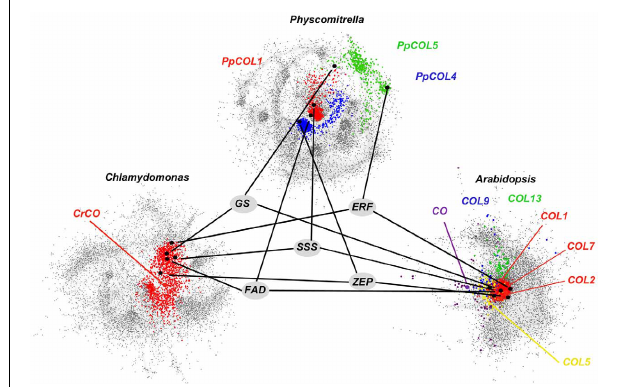
FIGURE 2 | Gene co-expression networks for Chlamydomonas , Physcomitrella , and Arabidopsis . In the networks, nodes represent genes and edges between nodes show significant co-expression relation between them. CrCO , PpCOLs, and AtCOLs and their neighborhoods (genes three edges apart) are highlighted with different colors. In the Chlamydomonas network (bottom left) CrCO and its neighborhood(red color) occupy a central position suggesting its role as an essential regulator in the Chlamydomonas transcriptome. In the Physcomitrella network (top center) PpCOL1 , PpCOL4 and their neighborhoods(red and blue colors, respectively) occupy a central position, while PpCOL5 (green color) is located in the periphery of the network. In the Arabidopsis network (bottom right) AtCOLs genes (different colors) are widely spread over the network indicating their role in multiple biological processes. Functional conservation, specialization and divergence during the evolutionary line of COLs can be observed in their neighborhood.Consistently, CrCO , PpCOLs , and AtCOLs genes are co-expressed with genes involved in light response ( ZEP, Zeaxanthin epoxidase ), starch metabolism ( SSS, solubale starch synthase ), nitrogen metabolism ( GS, cytosolic glutamine synthase ) and response to chemical stimulus ( ERF, ethylene response factor ) as it is suggested by their nearby localization in the corresponding